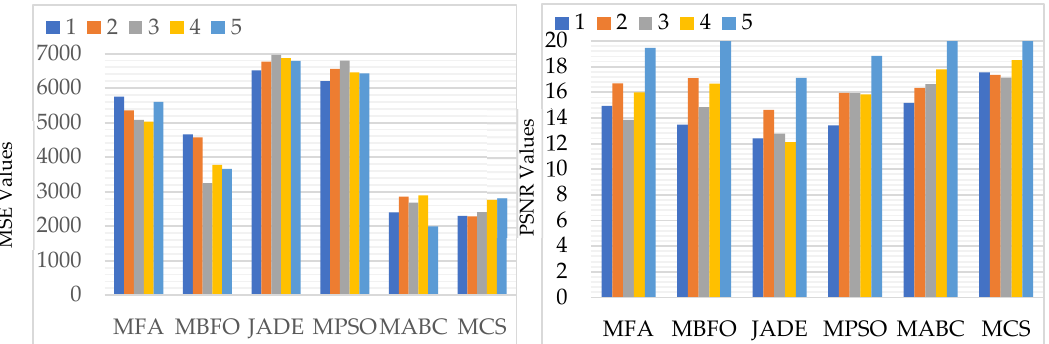
Figure 7. MSE and PSNR using different optimization algorithms with MCE.